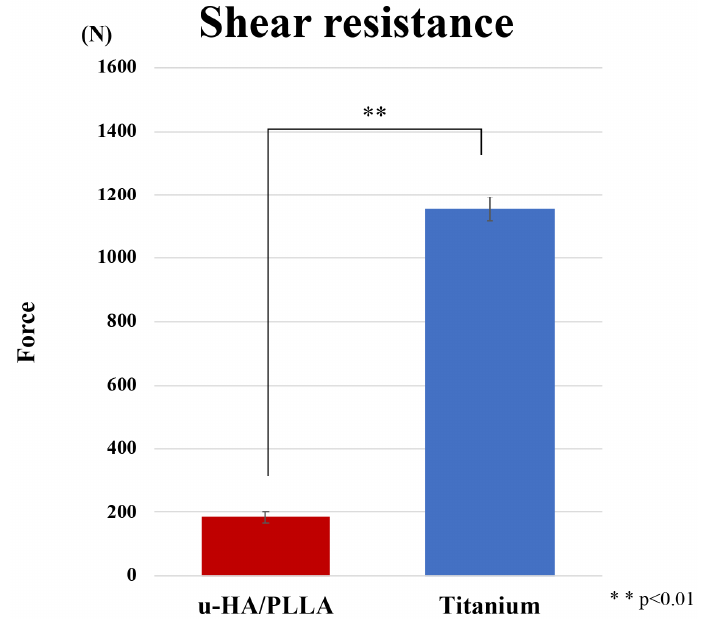
Figure 4. Comparison of titanium screw and unsintered hydroxyapatite (u-HA)/poly-L-lactide (PLLA) bioresorbable screw in the shear test.